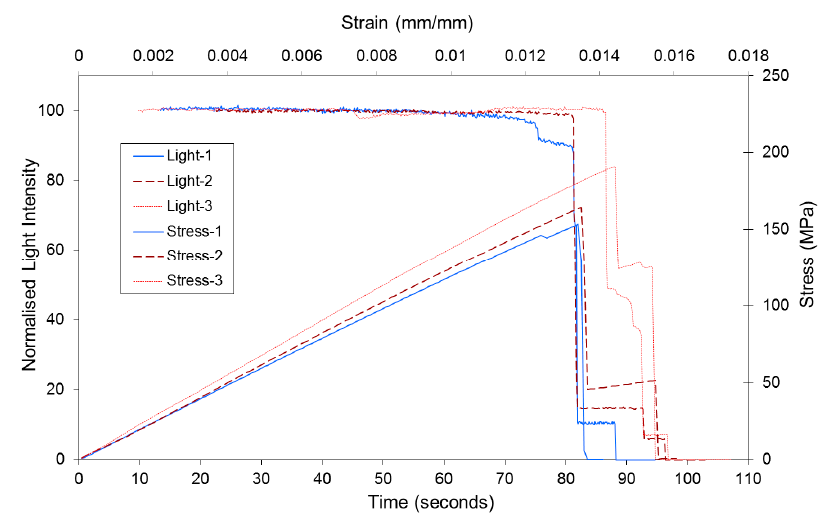
Figure 8. Representative graphs showing the normalised transmitted light intensity and applied stress as a function of time and strain for three SDOF composites.